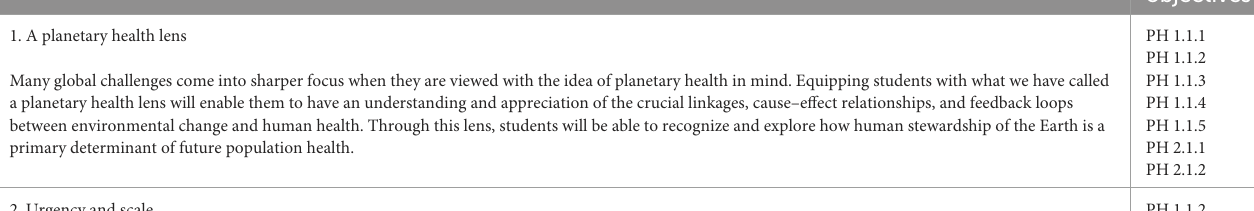
TABLE 2 Mapping of Planetary Health learning objectives against the Twelve cross-cutting principles for Planetary Health Education (19). Twelve cross-cutting principles for Planetary Health Education Learning